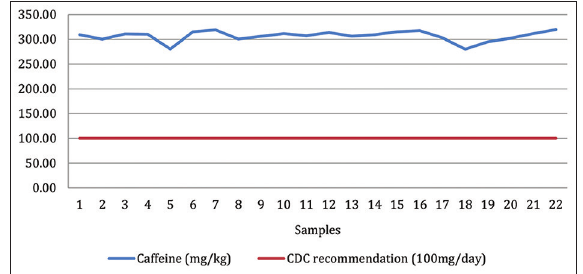
FIGURE 5: Comparison of obtained values with cdc and aap recommenda- tions for caffeine daily uptake for adolescents aged